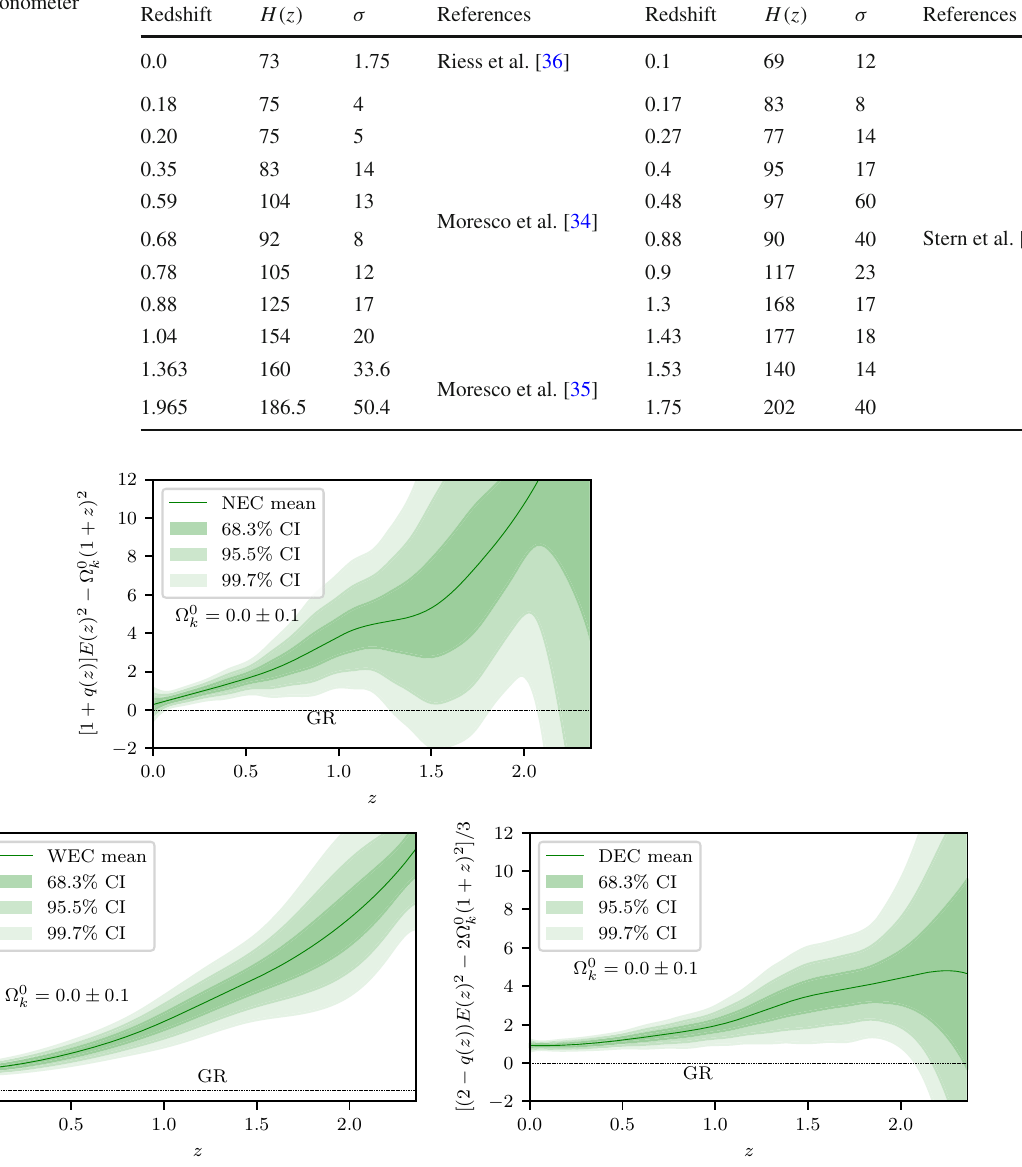
H ( z ) data. These MCMC results were obtained using a Gaussian prior on Ω 0 with zero mean and σ = 0 . 1. The black dashed line indicates k the GR